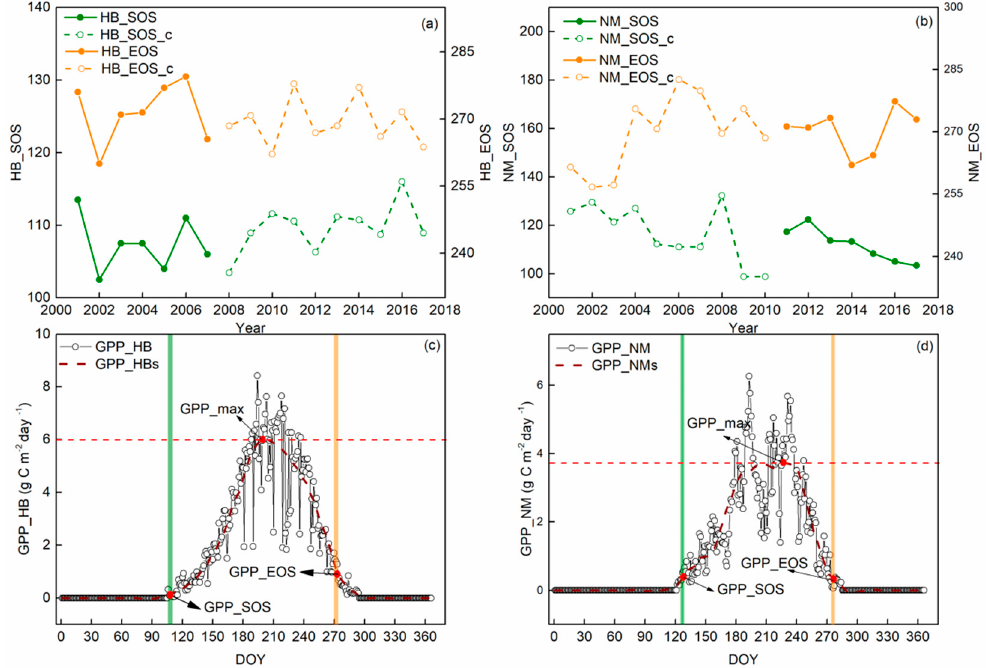
Figure 7. Interannual variability of the vegetation phenology periods ( a , b ), and an example on the determination of the threshold of carbon phenology periods in HB and NM ( c , d ) (2004). Solid points and lines represent field actual phenological values, and the dashed points and lines are the calibrated